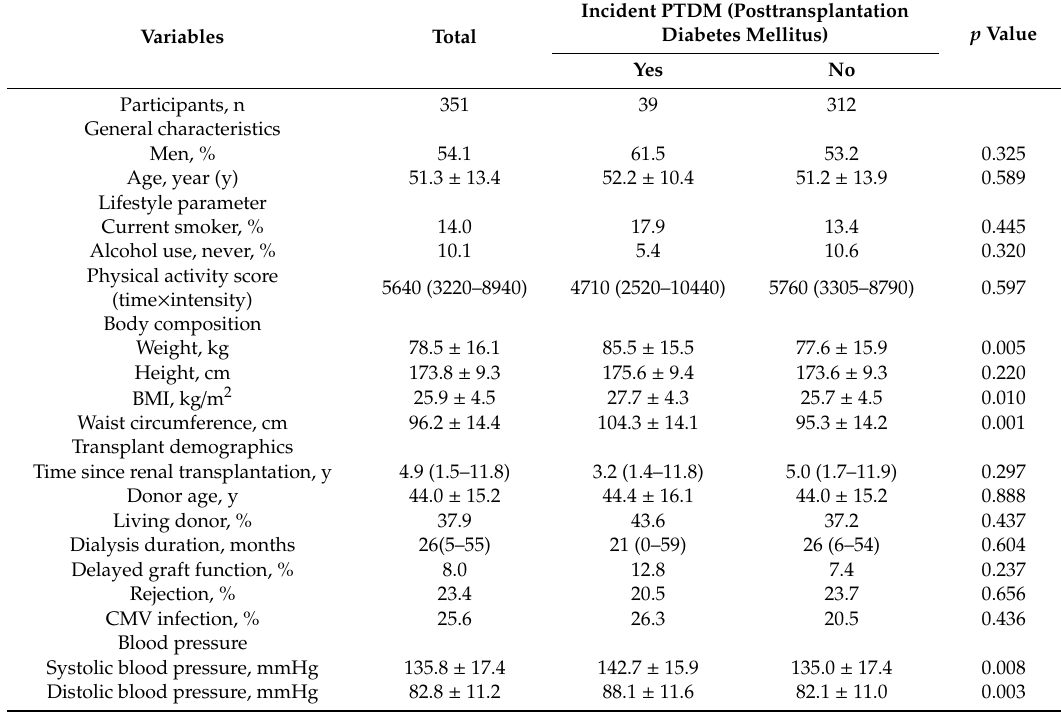
Table 1. Baseline Characteristics of 351 RTRs (Renal Transplant